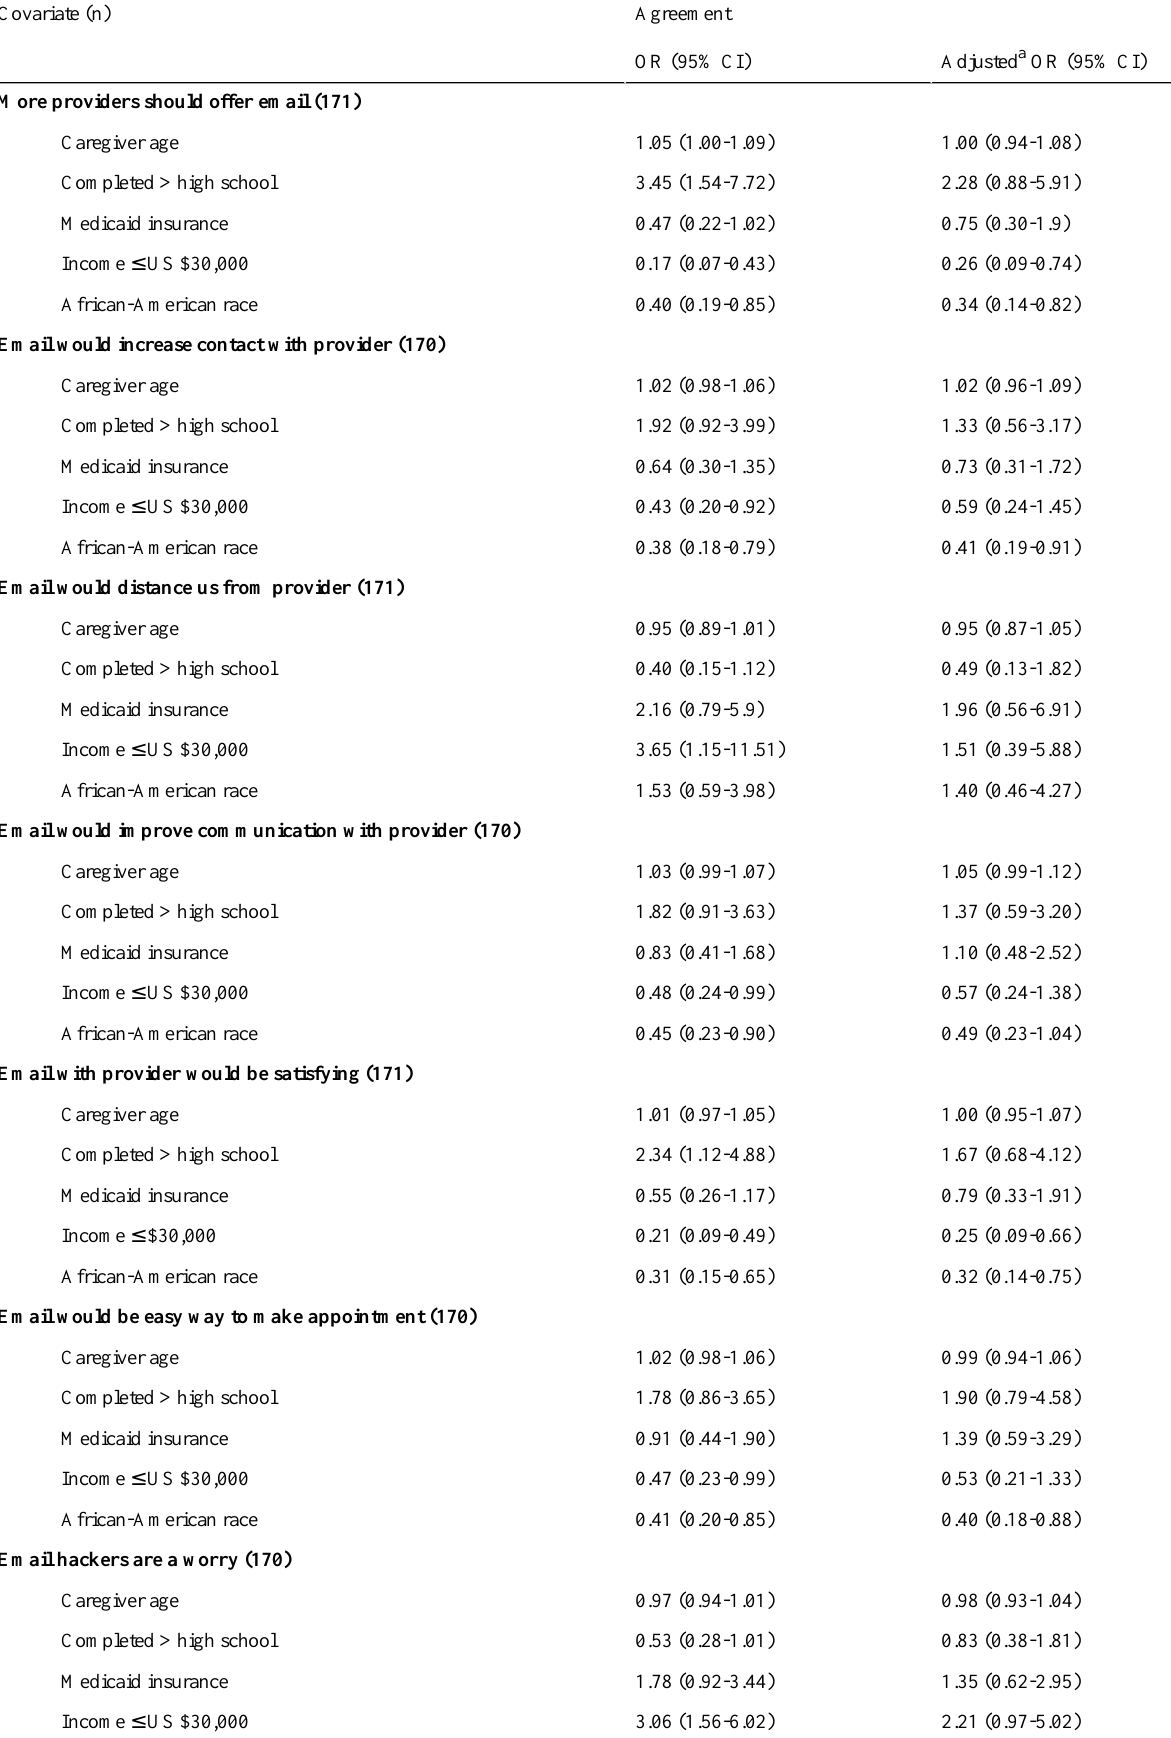
Table 5. Logistic regression of email users’attitudes as a function of age, education level, insurance type, family income, and